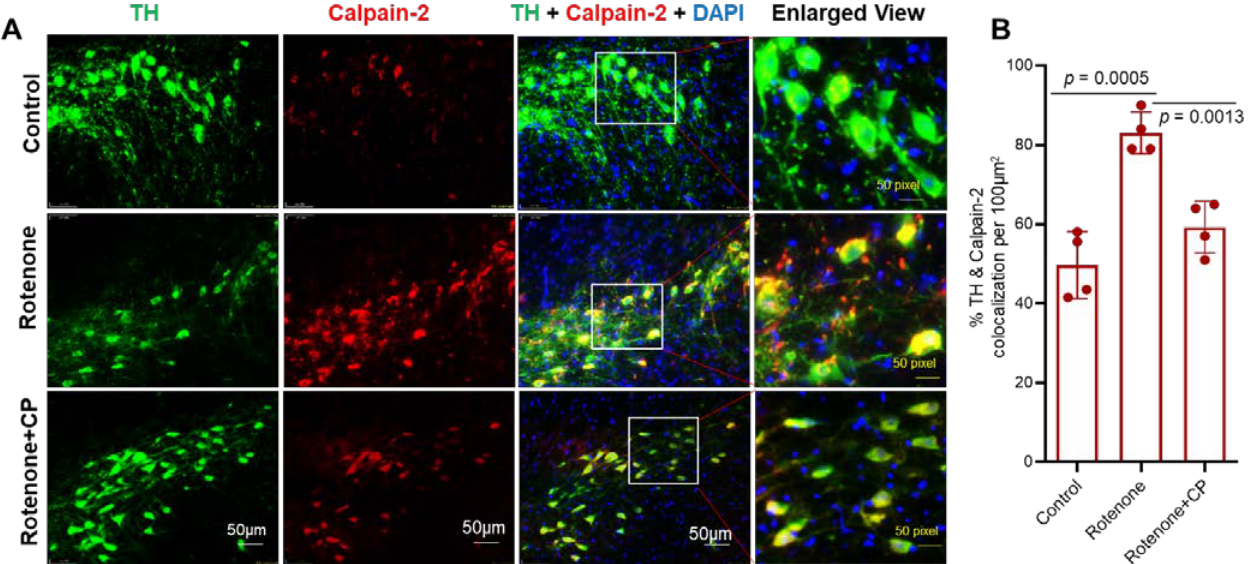
Figure 4. Calpain-2 expression was upregulated in SN DA neurons following rotenone administration, and it was not retained after CP treatment. ( A ) Representative images from the respective treatment groups showed SN DA neurons immunostained with TH (green) and calpain-2 (red). Co-localization of TH and calpain-2 (merged images) with DAPI (blue/purple) as a counter stain. Merged images showed less co-localization (yellow) of TH+ calpain-2 with a distinctly DAPI counter-stained nucleus (blue/purple color) after CP treatment. N = 3. ( B ) Quantitative analysis of TH+ and calpain-2+ cells colocalized per 100 µm 2 following CP treatment. N = 4.